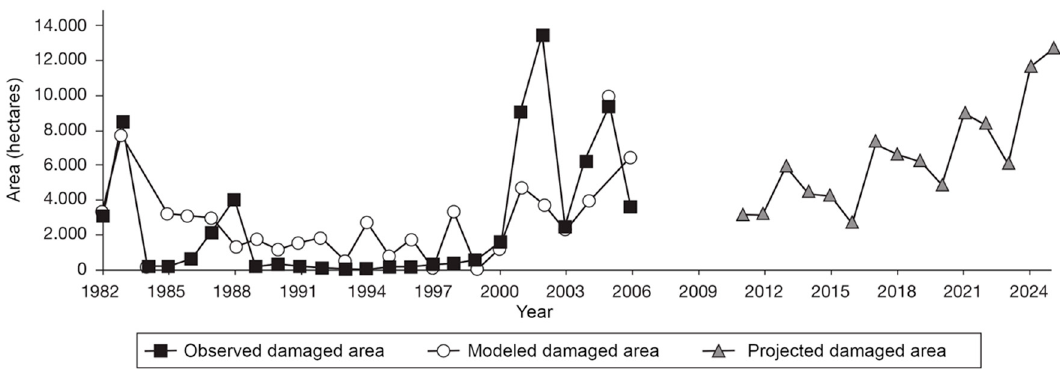
Figure 3. Observed, modeled, and projected damage of Dendroctonus frontalis in Honduras in a climate change scenario. Figure adapted from Rivera Rojas et al. [33] [available online http://revistas.inia.es/index.php/fs/article/view/1168].